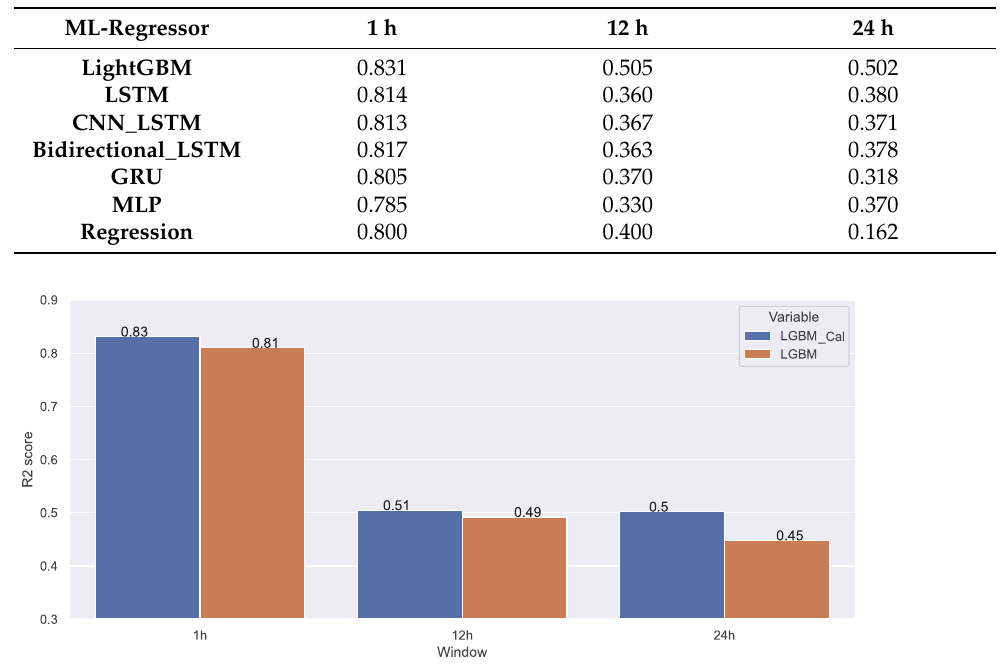
Figure 14. Continuous data distribution (avg number of occupants per hour). Table 7. R2 score for different ML approaches.